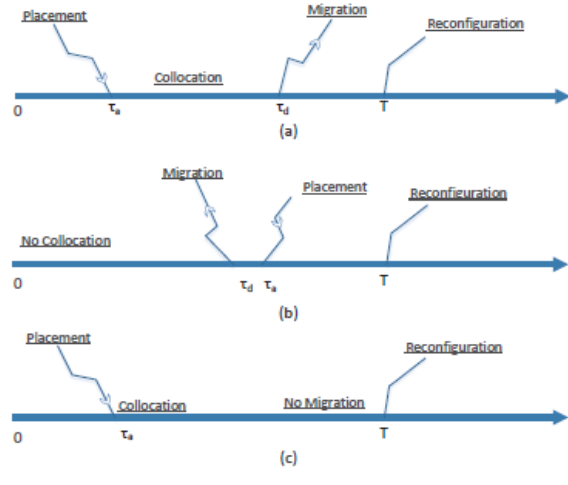
Figure. 1 Three possible placement scenarios for stackelberg game model